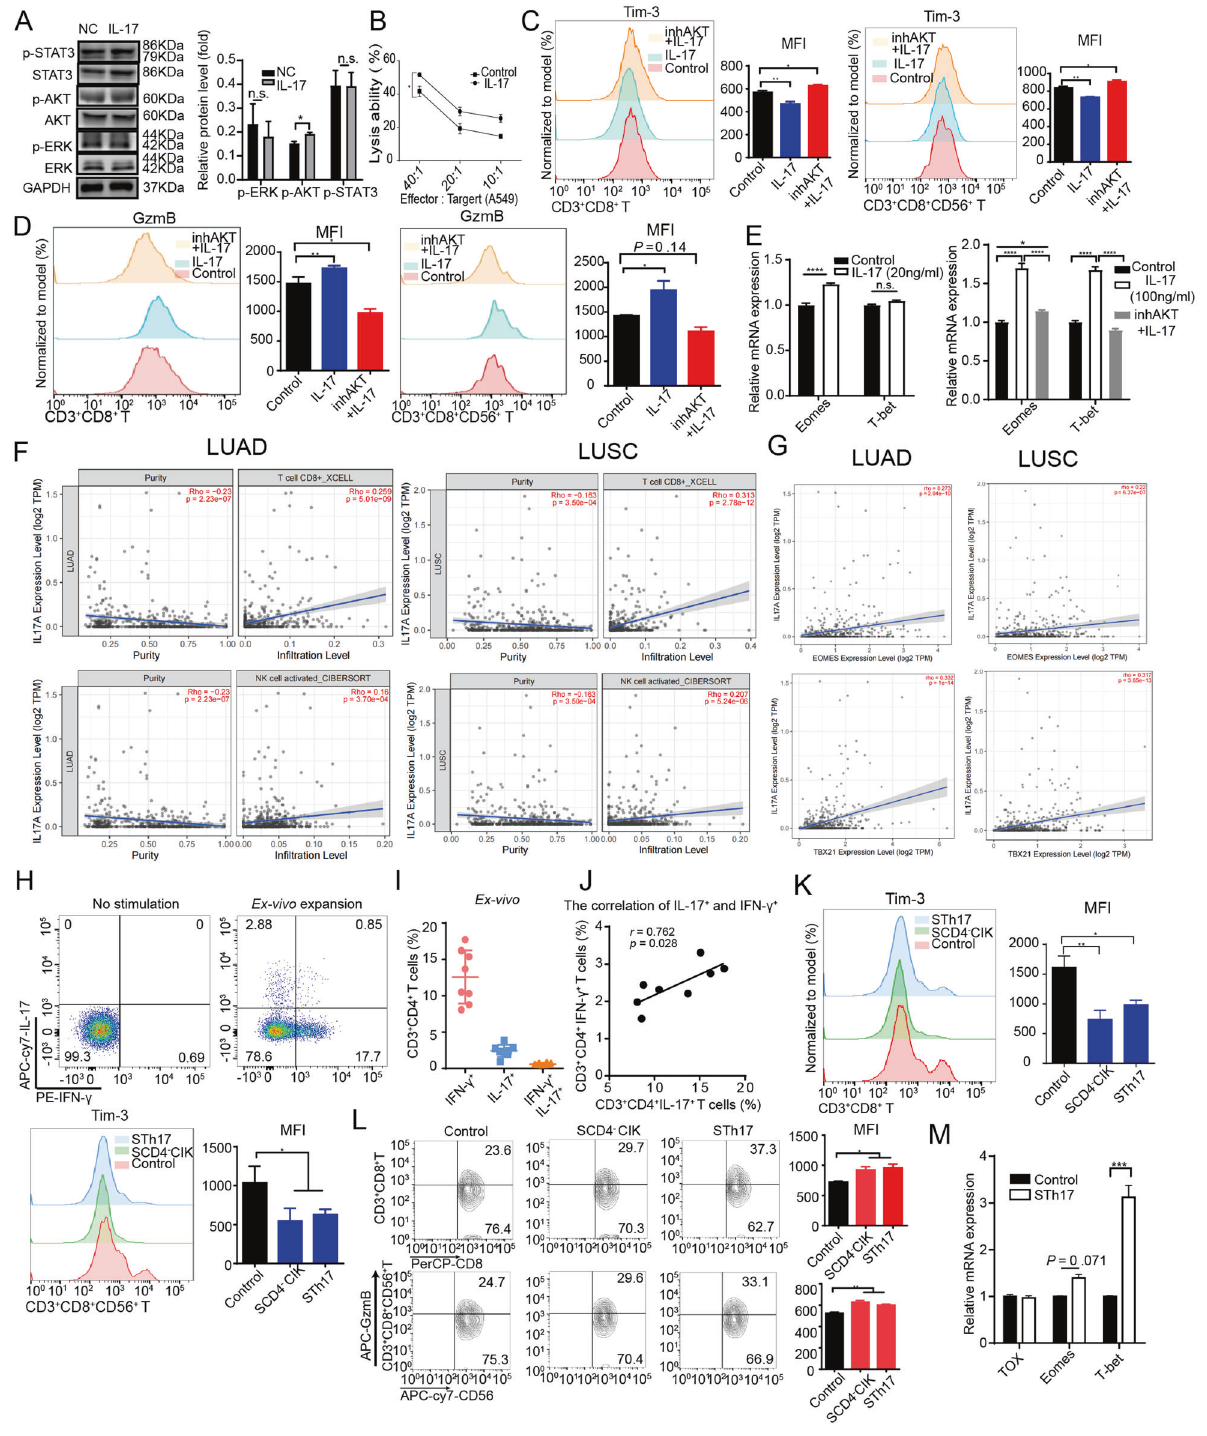
Fig. 5 CD4 + T cells improved the functions of CIK cells through IL-17A. A Western blot analysis of STAT3, AKT, and ERK phosphorylation in CD4 - CIK cells stimulated with rIL-17 (100 ng/ml) protein for 2 h. B The cytotoxicity of CD4 - CIK cells treated with or without rIL-17 against A549. C , D Flow cytometric analysis of Tim-3 and GzmB expression in CD3 + CD8 + T and CD3 + CD8 + CD56 + T cells treated with AKT inhibitor (Ly294002, 10 μ M), rIL-17 or PBS. E Relative mRNA quanti fi cation of Eomes and T-bet in CD4 − CIK cells treated with rIL-17, inhAKT, or PBS for 72 h. F Correlation analysis of IL-17A and CD8 + T cells in fi ltration or NK cells activated in fi ltration in LUAD and LUSC in TIMER public database. G Correlation analysis of IL-17A and EOMES or TBX21 in LUAD and LUSC in TIMER public database. H Flow cytometric examination of IL-17 and IFN- γ production in CIK cells before and after ex vivo expansion. I , J The relationship of Th1 and Th17 cell groups ( n = 8). K Flow cytometric analysis of Tim-3 expression in CD3 + CD8 + T and CD3 + CD8 + CD56 + T cells treated with tumor-conditioned medium in the presence of Th17 cells, CD4 + T cells or absence of these cells. L Flow cytometric determination of GzmB production in CD3 + CD8 + T and CD3 + CD8 + CD56 + T cells. M Relative mRNA quanti fi cation of Tox, Eomes, and T-bet in CD4 − CIK cells treated with tumor-conditioned medium for 72 h. Error bars indicate SEM, * P < 0.05, ** P < 0.01, *** P < 0.001, and **** P < 0.0001 (one-way ANOVA or Student's t test). Cell Death and Disease (2022)